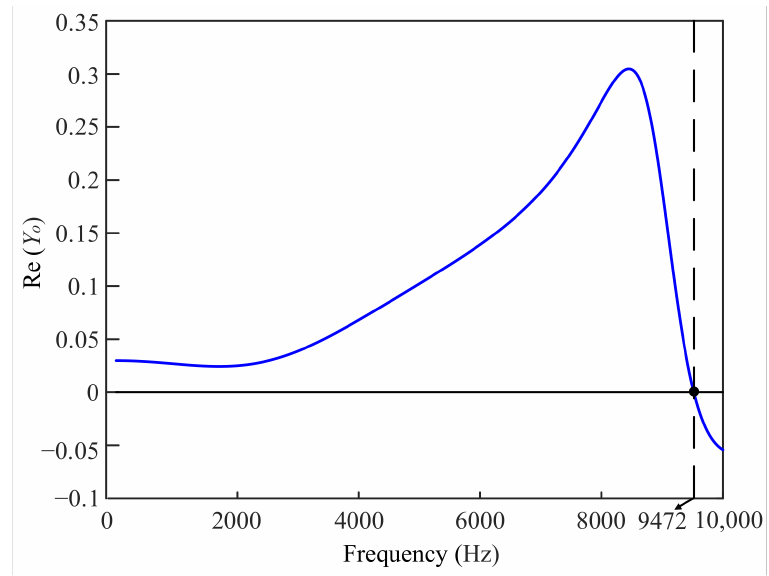
Figure 12. Frequency characteristic curve of Re { Y o ( j ω